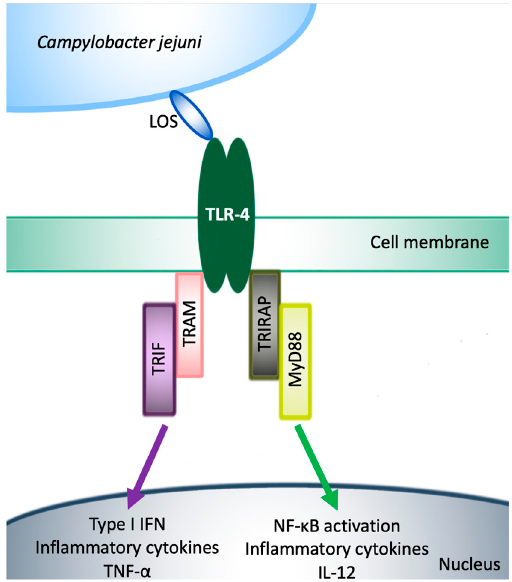
Figure 3. C. jejuni LOS and TLR-4 Signaling. The activation of TLR-4 leads to the synthesis of inflammatory mediators via two different pathways; TRIF-TRAM pathway, which induces the secretion of tumor necrosis factor alpha and TIRAP-MyD88, which is responsible for the LOS response and NF- κ B activation.